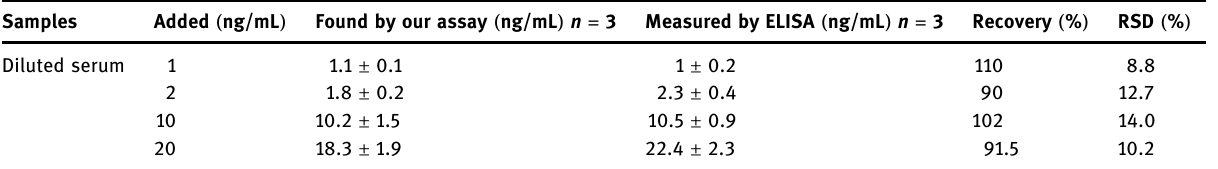
Table 2: Recovery test for serotonin detection in real samples Samples Added ( ng/mL ) Found by our assay ( ng/mL ) n = 3 Measured by ELISA ( ng/mL ) n = 3 Recovery ( %